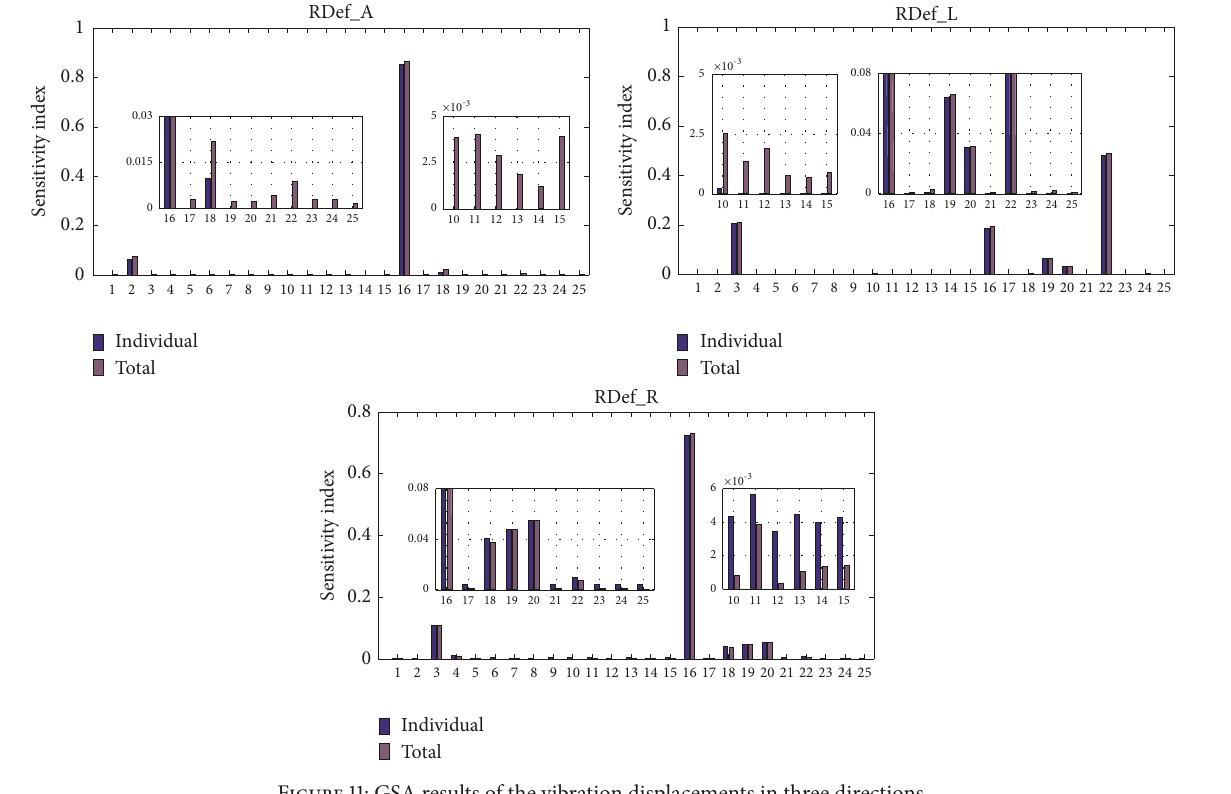
Figure 11: GSA results of the vibration displacements in three directions.